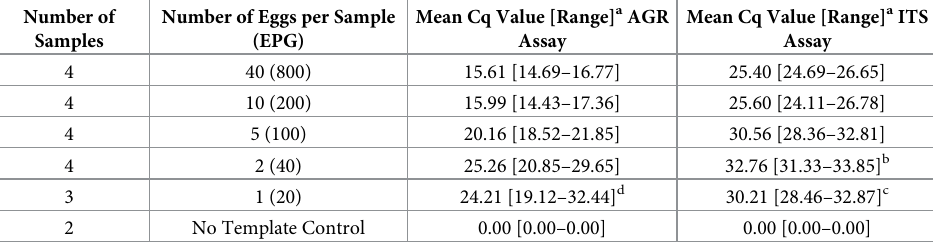
Table 2. Evaluation of limits of detection utilizing DNA extracts from spiked stool samples.